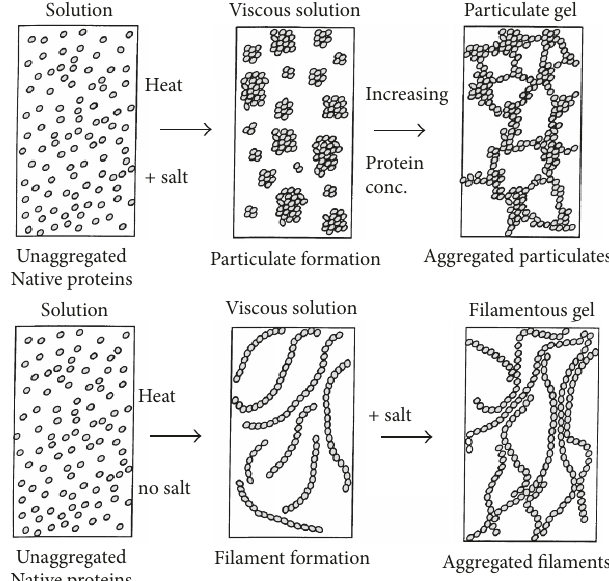
Figure 2: Illustration of gel formation (adapted from Bryant and Julian McClements